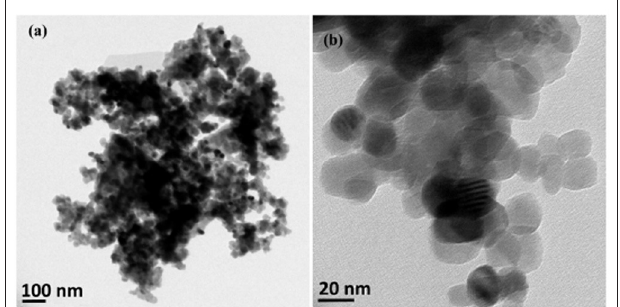
FIGURE 2 | High resolution TEM images of CuNPs obtained from WPCBs. These NPs were prepared from (a) ammoniacal ammonium chloride and (b) ammoniacal ammonium carbonate leachant by ascorbic acid in presence of cetyltrimethylammonium bromide (CTAB) as modifier. These images were